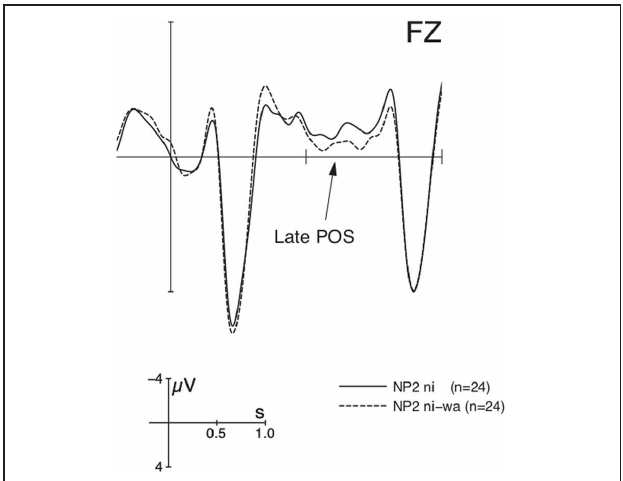
FIGURE 3 | Grand average ERPs ( n = 24) time-locked to the dative NP (onset at the vertical bar) at NP2 in Experiment 1 for the comparison of the non- wa -marked vs. wa -marked dative NPs averaged over all discourse contexts. Negativity is plotted